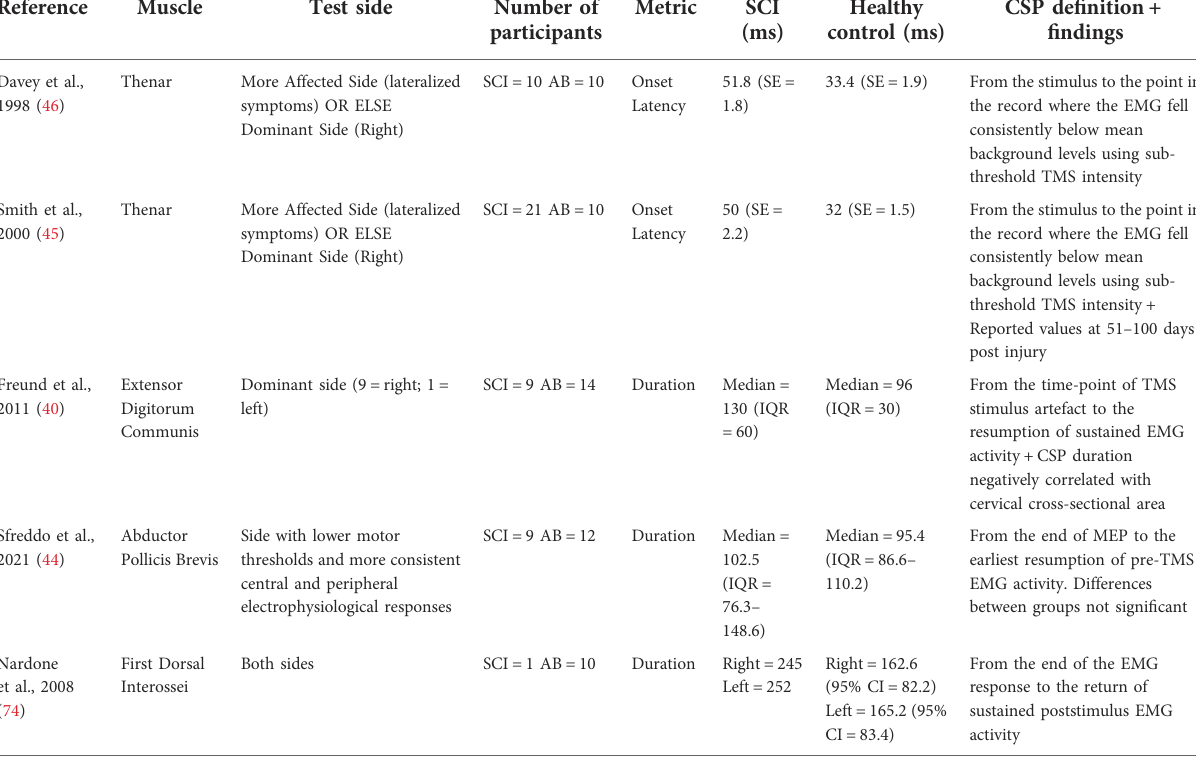
TABLE 5 Contralateral silent period latency and duration fi ndings in individuals with and without spinal cord